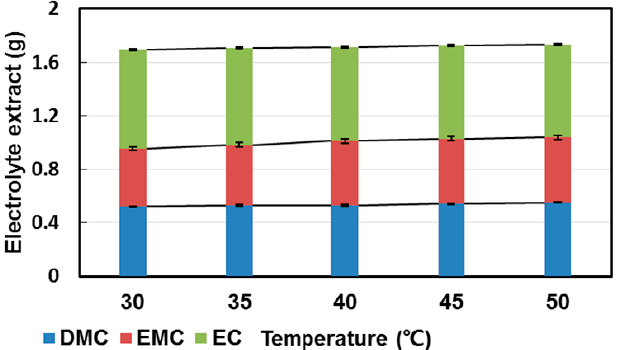
Figure 12. Compositions of the extracts corresponding to GC-FID measurements. Green, top: EC; crimson, middle: EMC; blue, bottom: DMC [164].